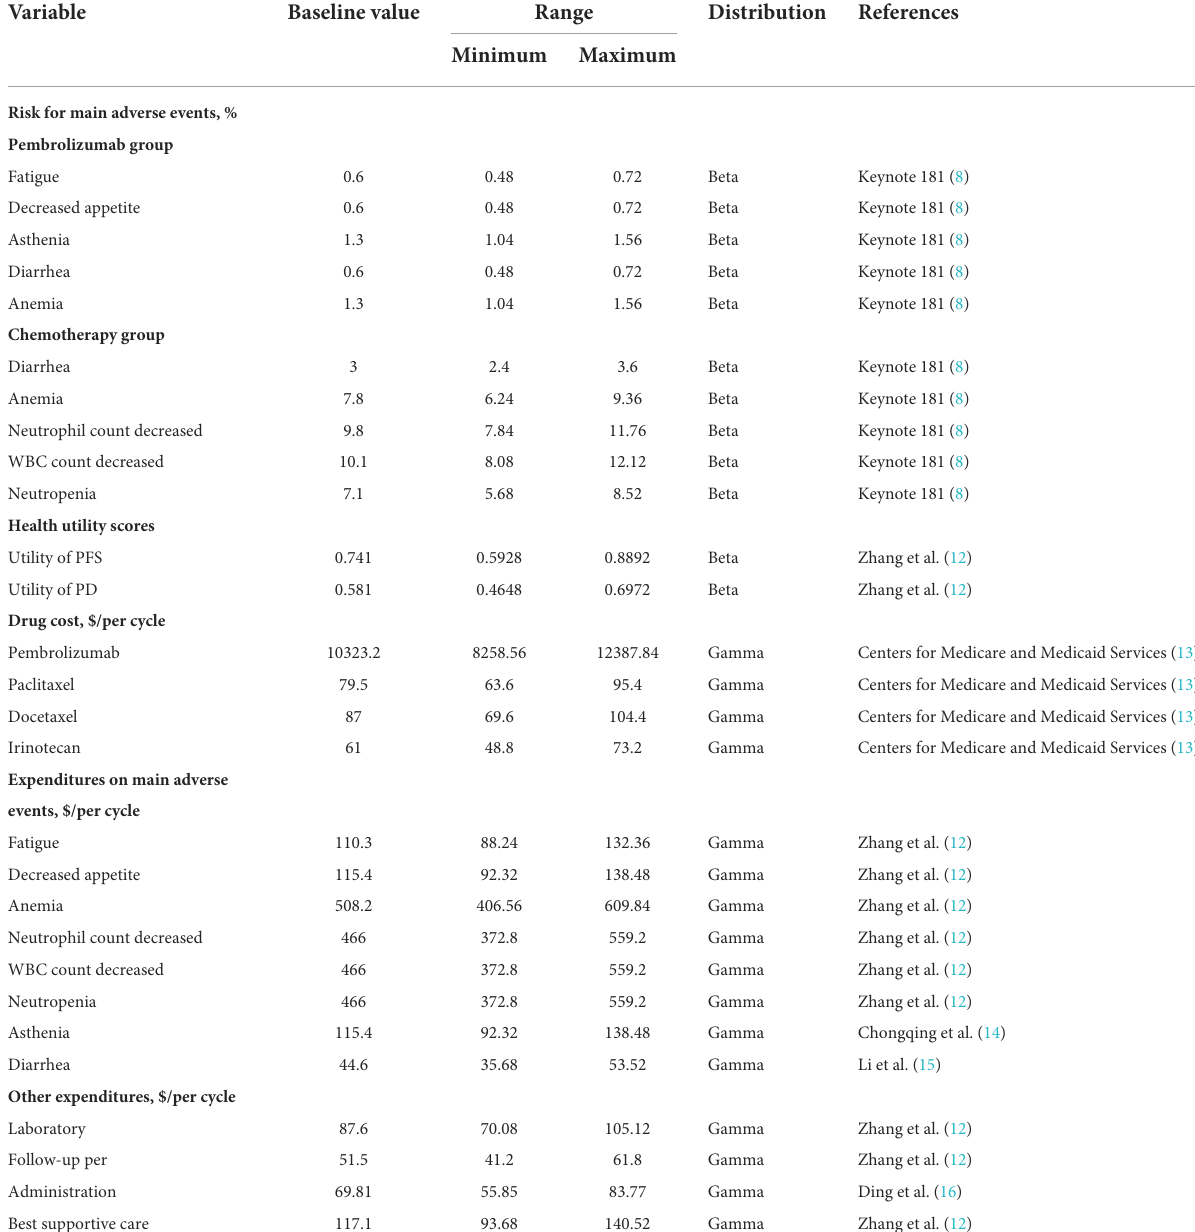
TABLE 2 Key input parameters of